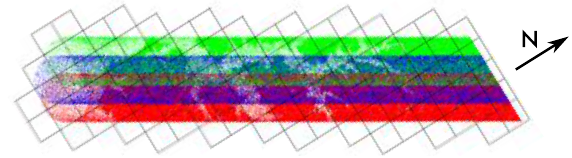
Figure 7. 1 x 1 km tiling of Easton dataset flight lines.